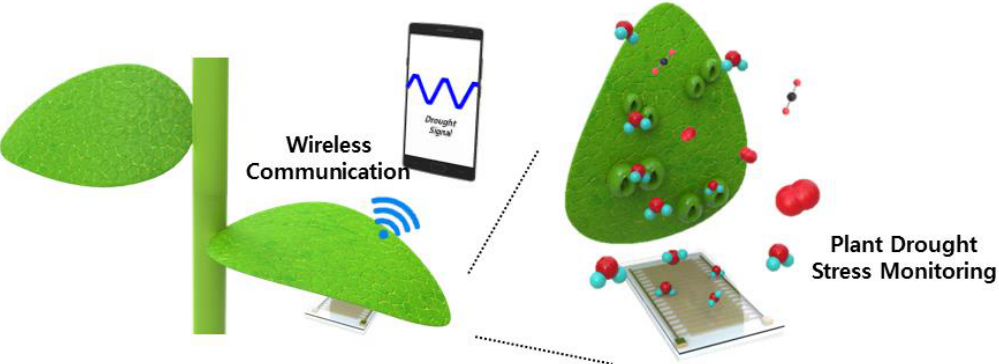
Figure 1. Scheme of the flexible PI-based plant drought stress monitoring system.